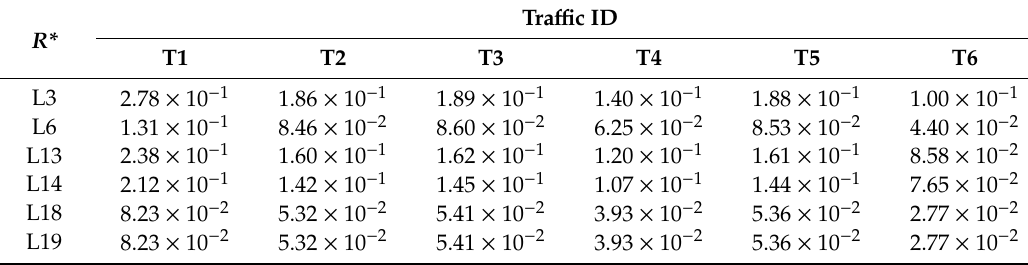
Table 7. Risk of collision for non-symmetrical